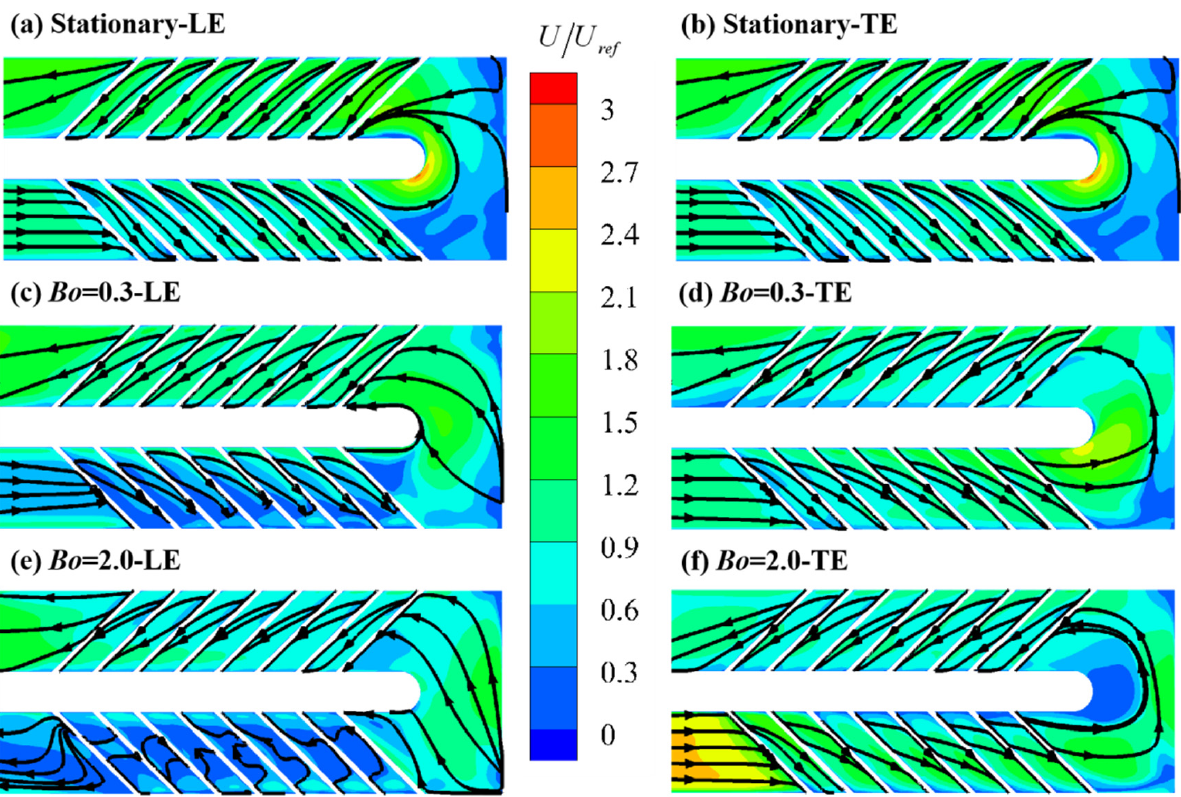
Figure 7. 2-D non-dimensional velocity ( U / U ref ) contour and streamline in meridian planes at Z / H = 0.9 (near LE) and 0.1 (near TE) of ribbed channel.